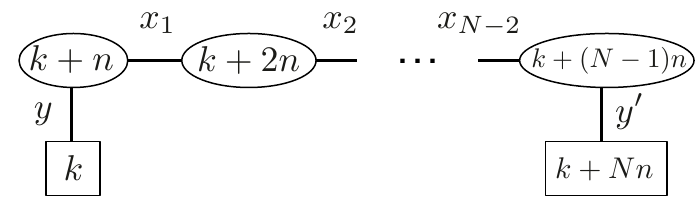
Figure 9 . A uniformly rising